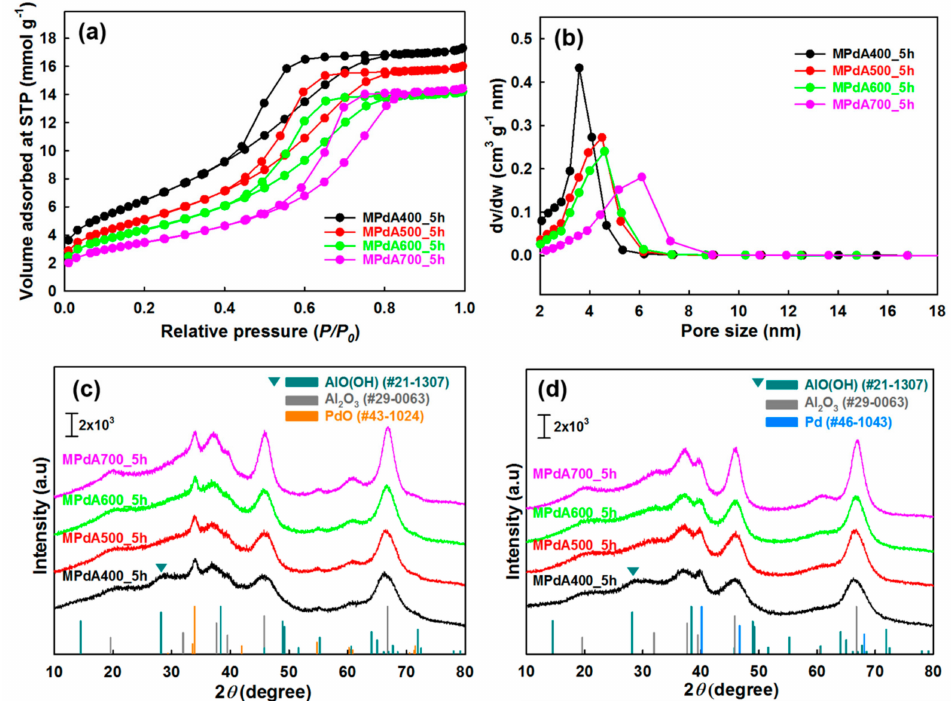
Figure 1. ( a ) Nitrogen adsorption-desorption isotherms; ( b ) pore size distribution curves; ( c ) XRD patterns of the mesoporous Pd-Al 2 O 3 (MPdA) catalysts calcined at di ff erent temperatures for 5 h; ( d ) XRD patterns of the MPdA catalysts reduced at 350 ◦ C for 3 h; X-ray source: Cu K α (1.5406